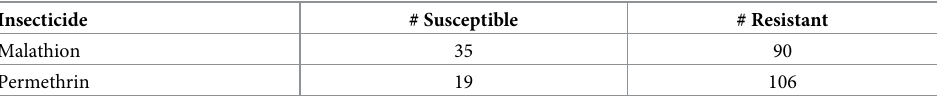
Table 3. Numbers and resistance phenotypes of the 125 Culex quinquefasciatus families in this study. Each family was split and tested for resistance to both insecticides. A single individual from each family was then